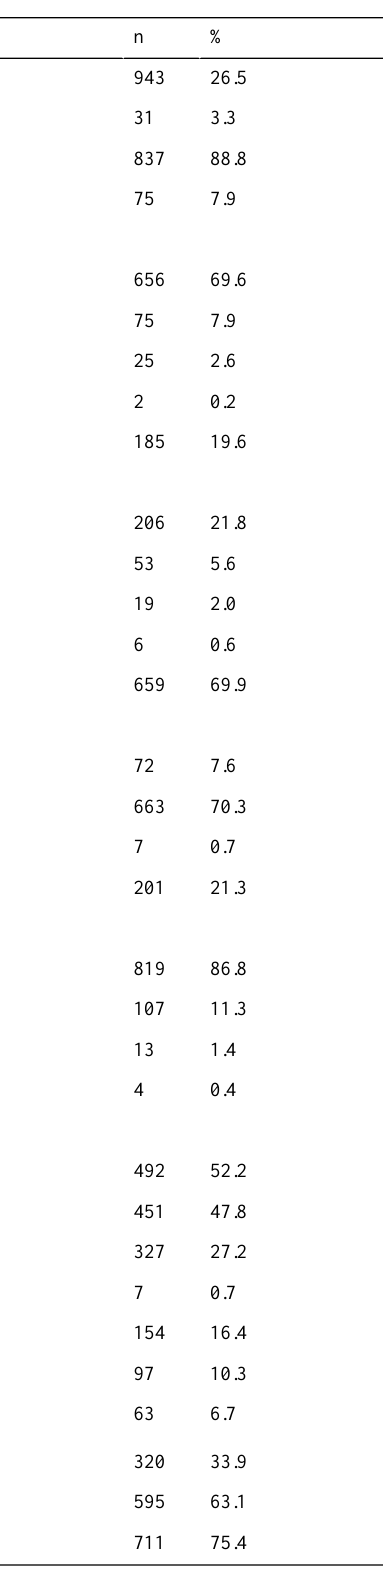
Table 1. Baseline sample descriptive statistics